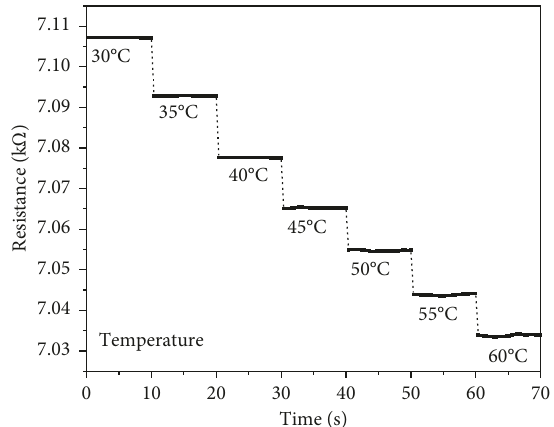
Figure 5: The relationship between the temperature and the LIG sensor resistance corresponding to the